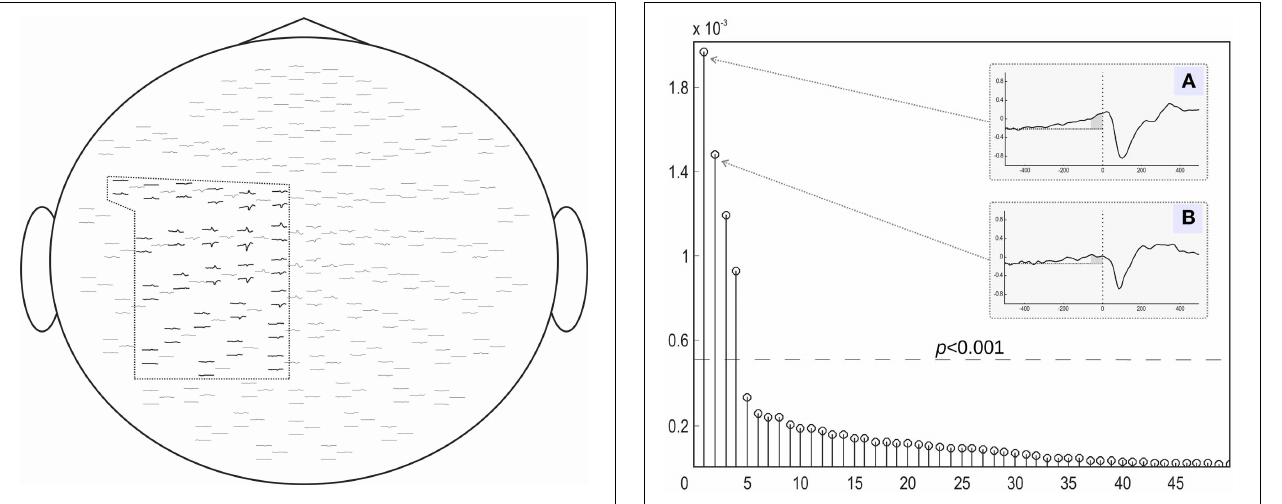
FIGURE 7 | Relative contribution of independent components of the evoked magnetic activity accompanying movement onset. All derived components (abscissa) are ranked according to the amount of mutual information with the expanded stimulus signal. The MI values were normalized to the overall amount of information (ordinate). (A,B) The stimulus-locked average time courses of the two components (4 and 1) with the greatest share of mutual information with expanded stimulus signal. Abscissa: time (ms) in relation to the movement onset. Ordinate: component amplitude (arbitrary units). Low-pass filter with 30 Hz cutoff frequency was applied. Movement onset is shown by the vertical dotted line. Horizontal dotted line represents the background signal level. Dark-gray area shows time interval of exponential growth preceding movement onset of component